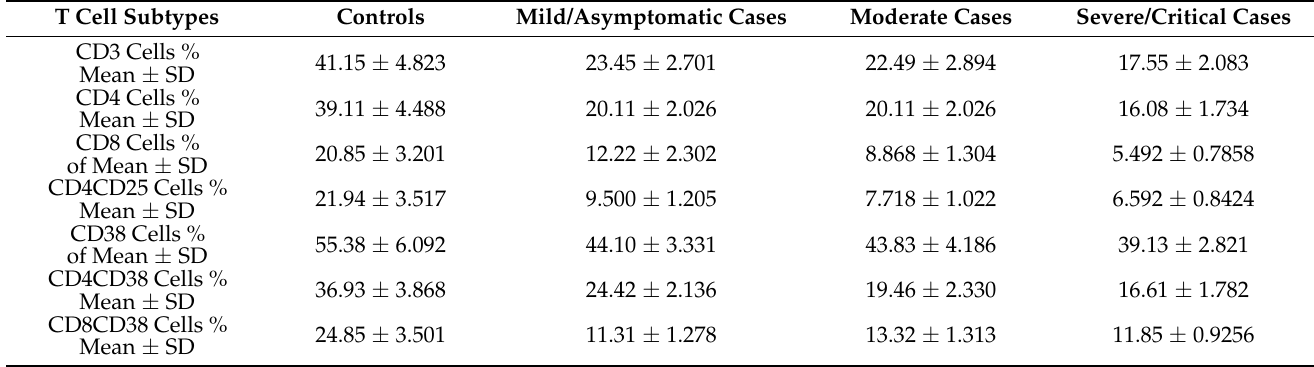
Table 4. Comparison of the percentage of total CD3 + T cells and different T cell subtypes, Th CD4 + , Tc CD8 + , and Treg CD4 + CD25 + , between different COVID-19 patient groups and